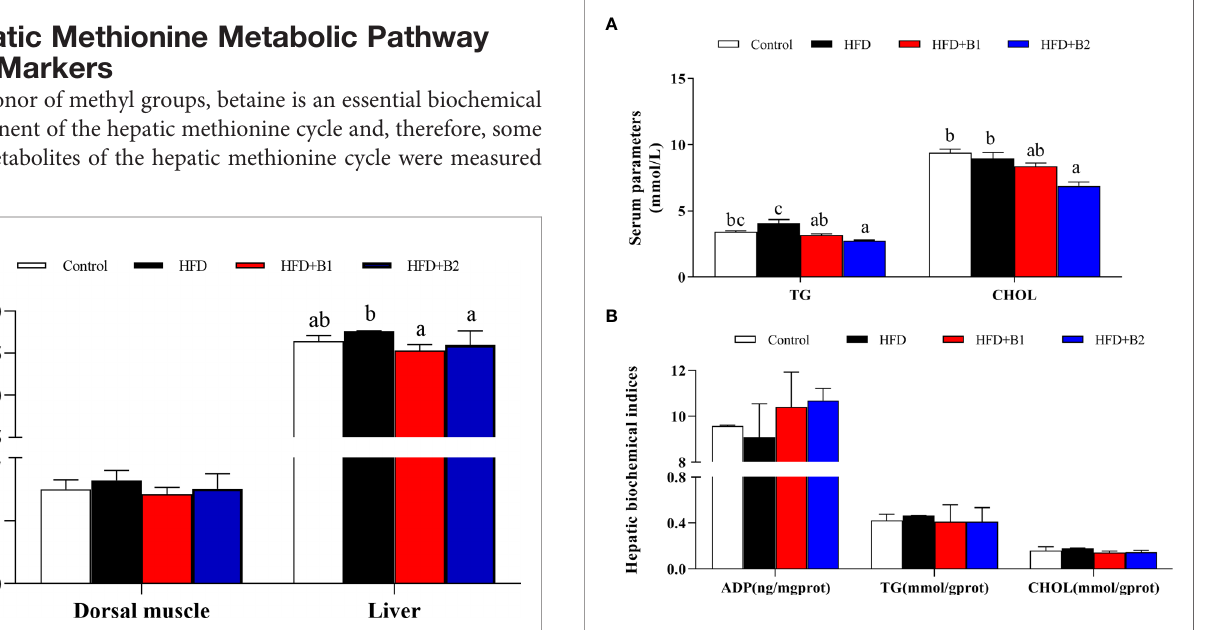
FIGURE 3 | Serum and hepatic parameters of juvenile black seabream ( Acanthopagrus schlegelii ) (% wet weight) fed the experimental diets (Control: 11% crude lipid; HFD: high-fat diet; HFD+B1: HFD +betaine (10g/kg); HFD+B2: HFD + betaine (20 g/kg)) for 8 weeks. (A) Serum triacylglycerol (TG) and cholesterol (CHOL) contents. (B) hepatic adiponectin (ADP), TG and CHOL contents. Values are means (n=3) with standard errors represented by vertical bars. Mean values for the same column with different letters were signi fi cantly different ( P <